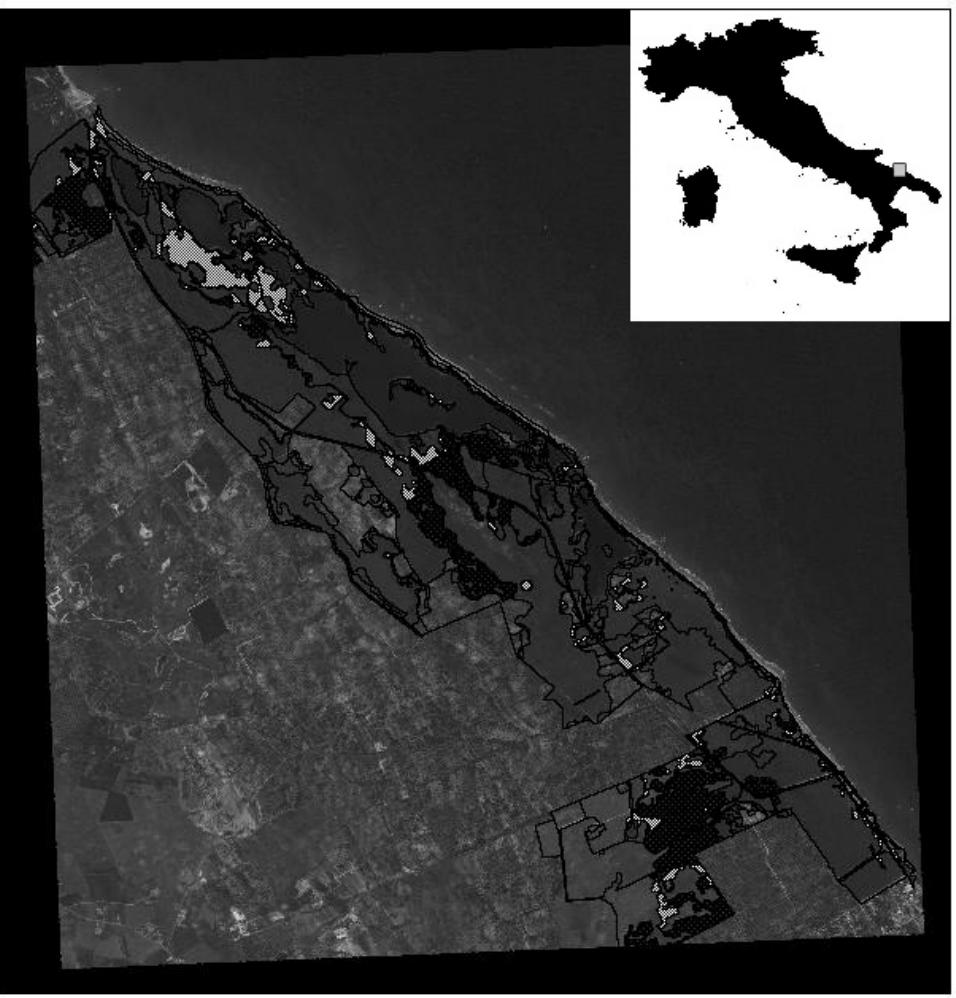
Figure 1: LPH/MPH and TPH habitats in Le Cesine protected